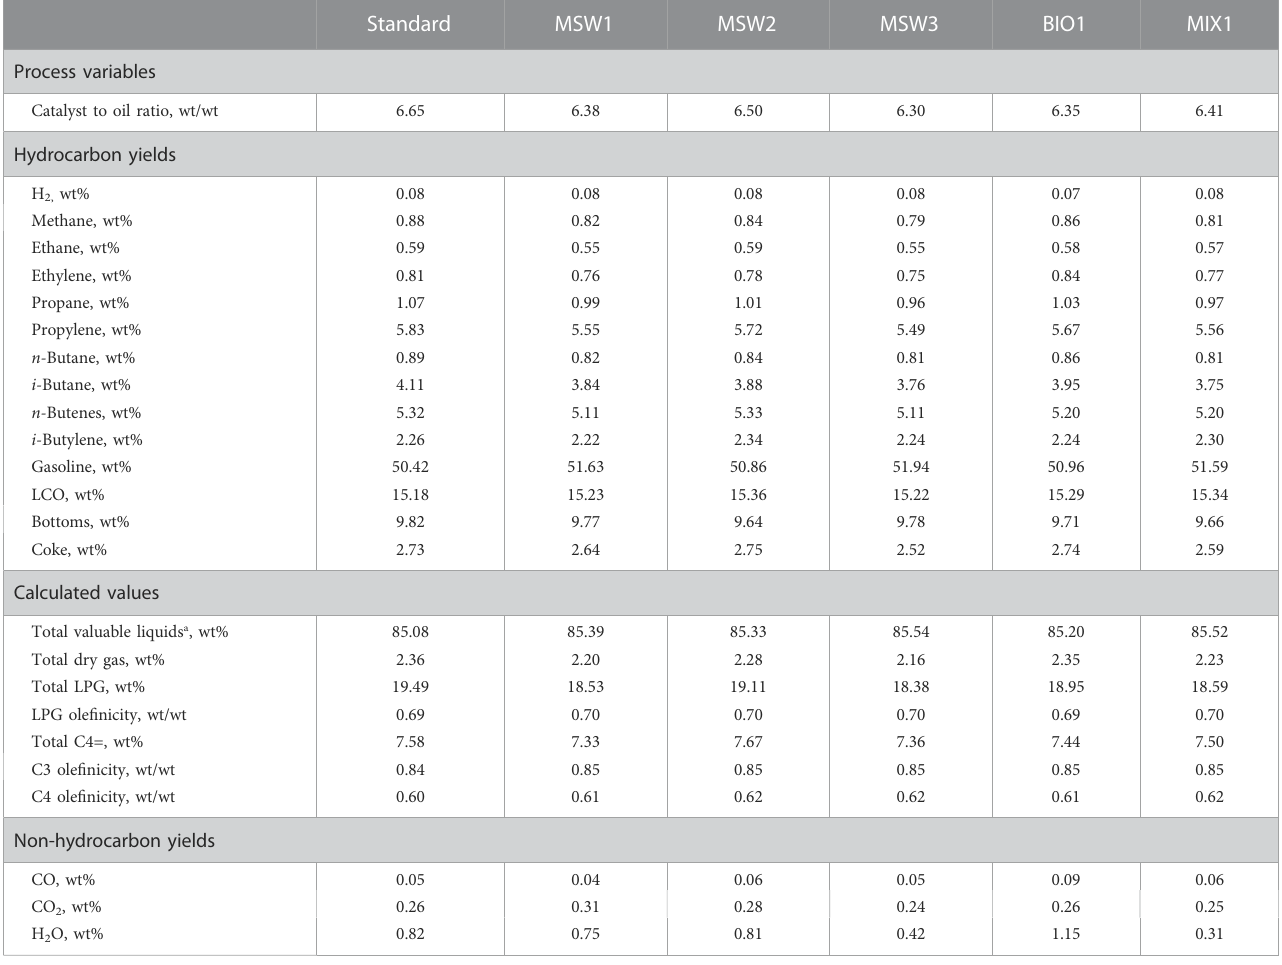
TABLE 4 Catalytic cracking evaluation of all feeds at constant conversion (75